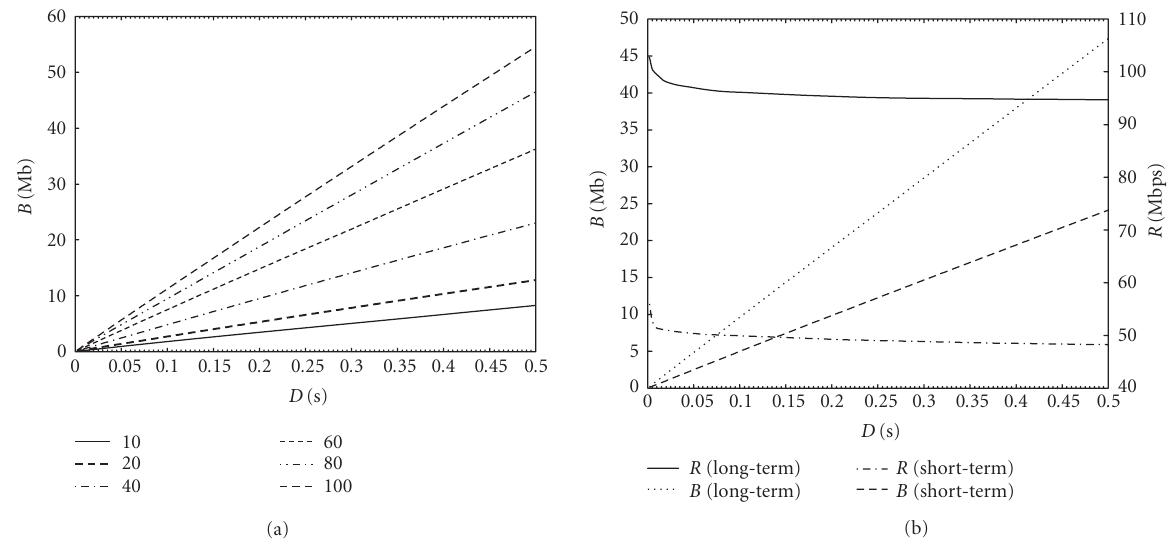
Figure 7: (a) B parameter for di ff erent aggregates, (b) dimensioning for Qbone-shaped tra ffi c.